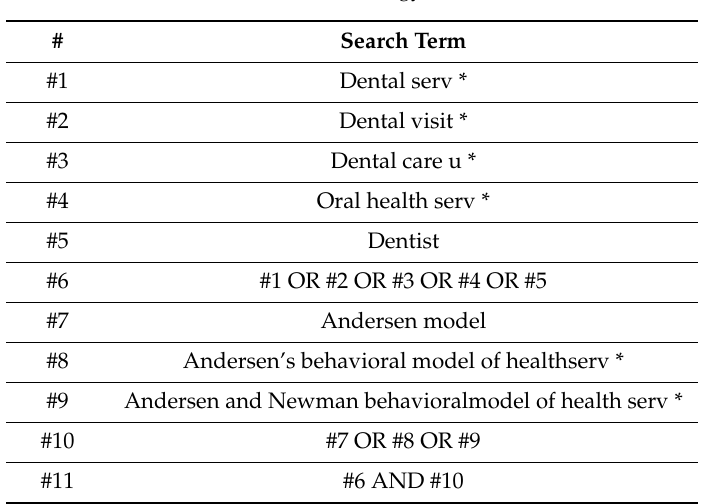
Table A1. Search strategy